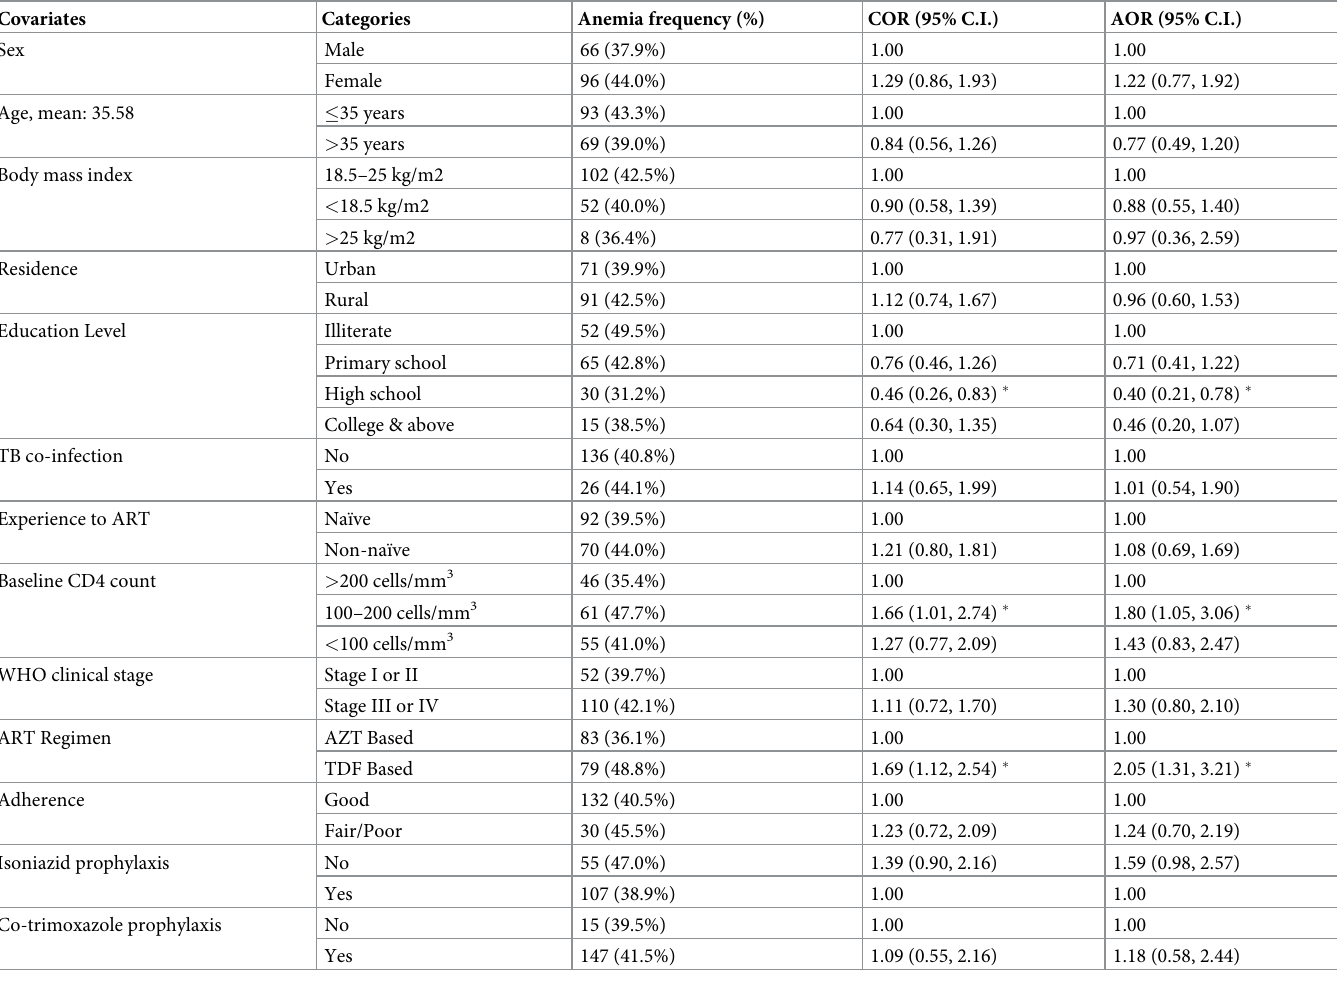
Table 3. Possible predictors of anemia among adults on HAART in Northeast Ethiopia: